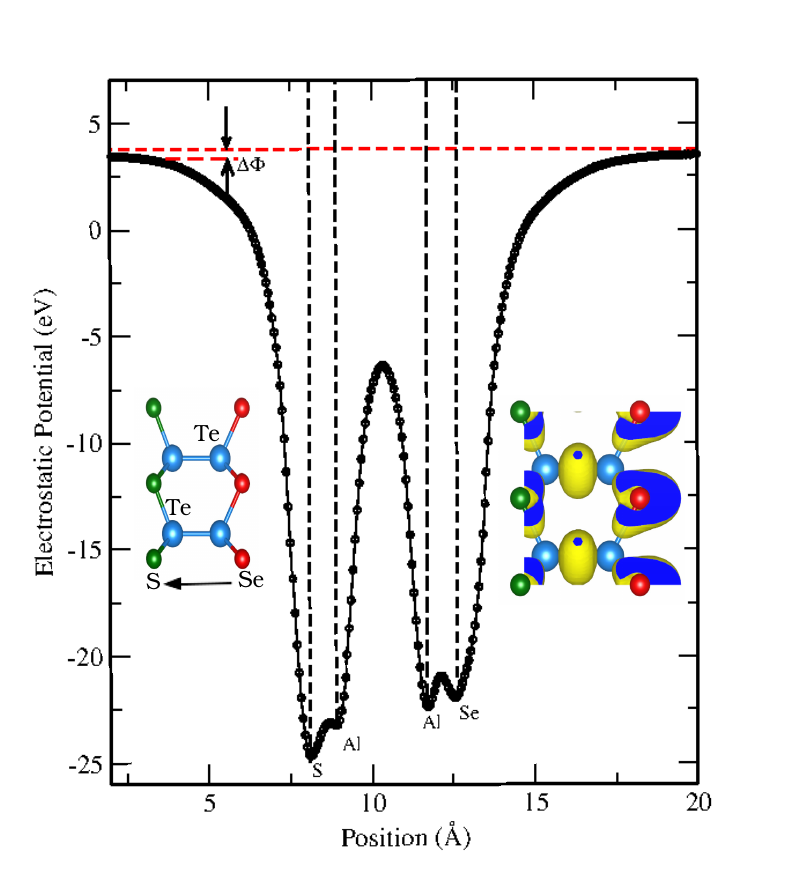
Figure 3. Planar average of the electrostatic potential energy for the Al 2 SSe. In the inset, the electron localization function (ELF) of the Al 2 SSe. The arrow indicates the direction of the local electric